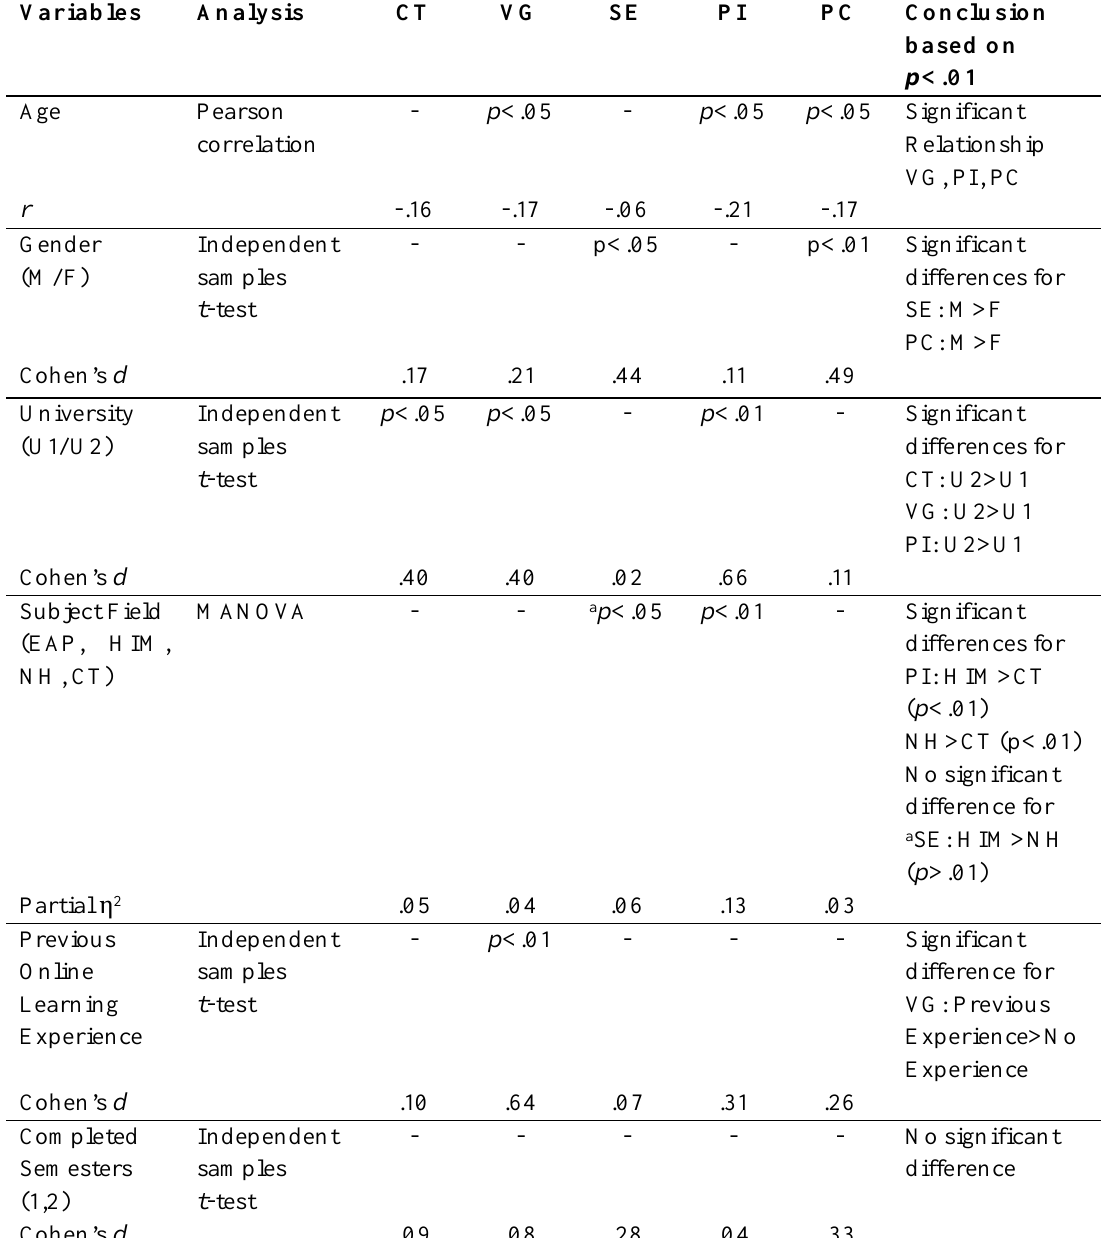
Table 2 Summary of Results for Research Question